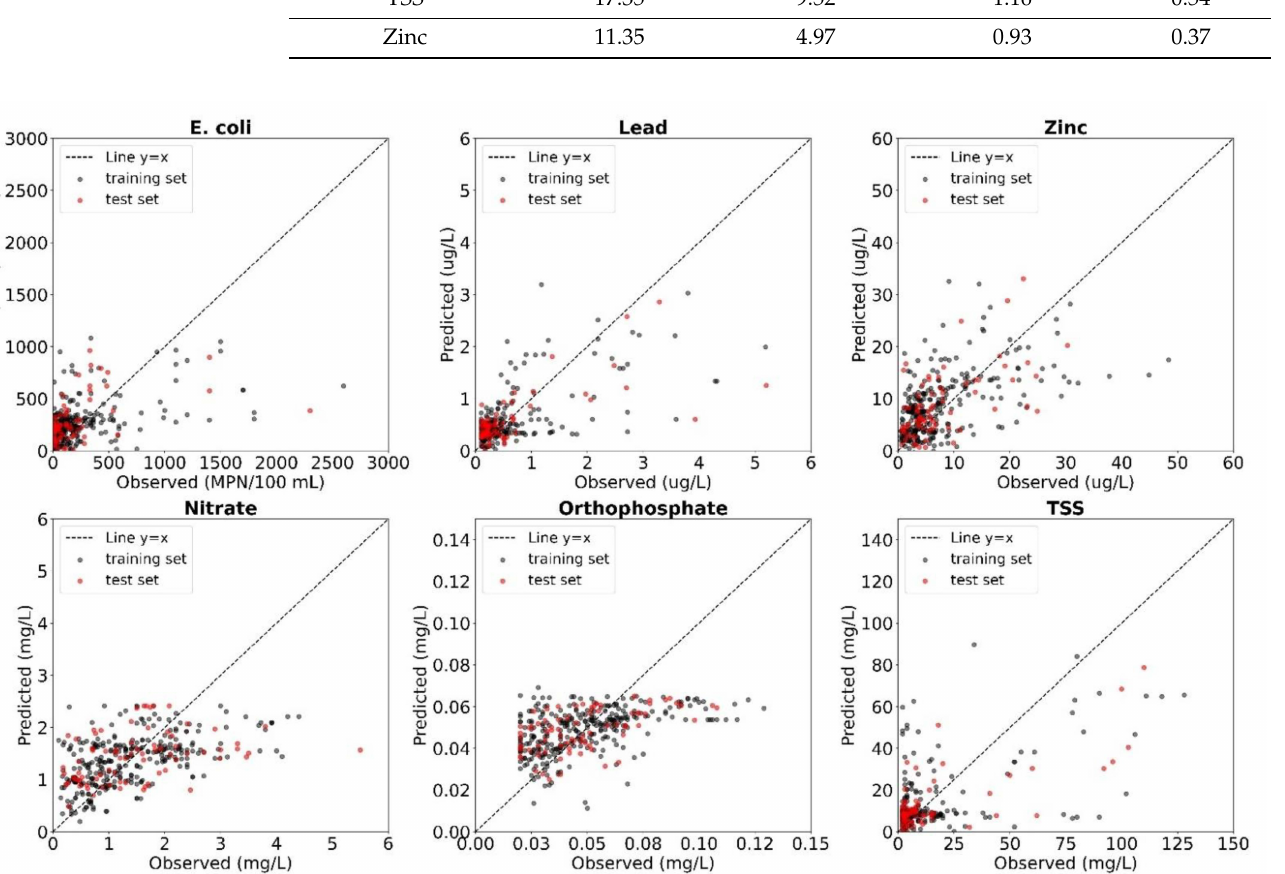
Figure 5. Comparison between observed and OLS-predicted pollutant